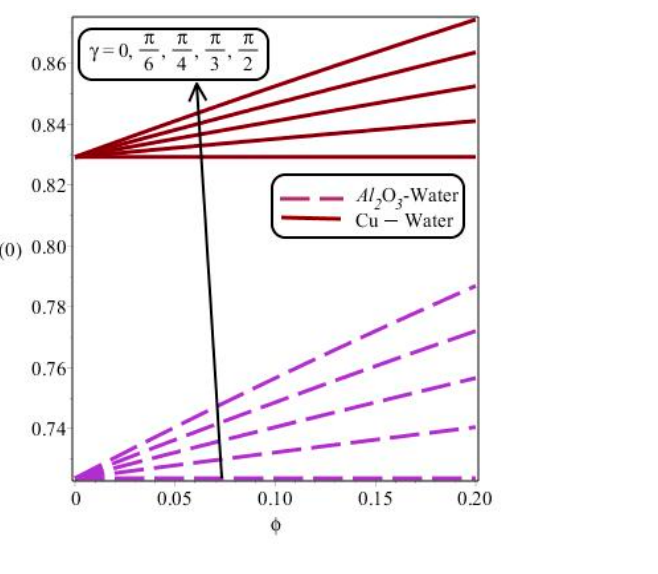
Figure 9. ( a , b ) Impact of β on temperature profile with K 1 = 0.7, γ = π /4, and M = 0.2.